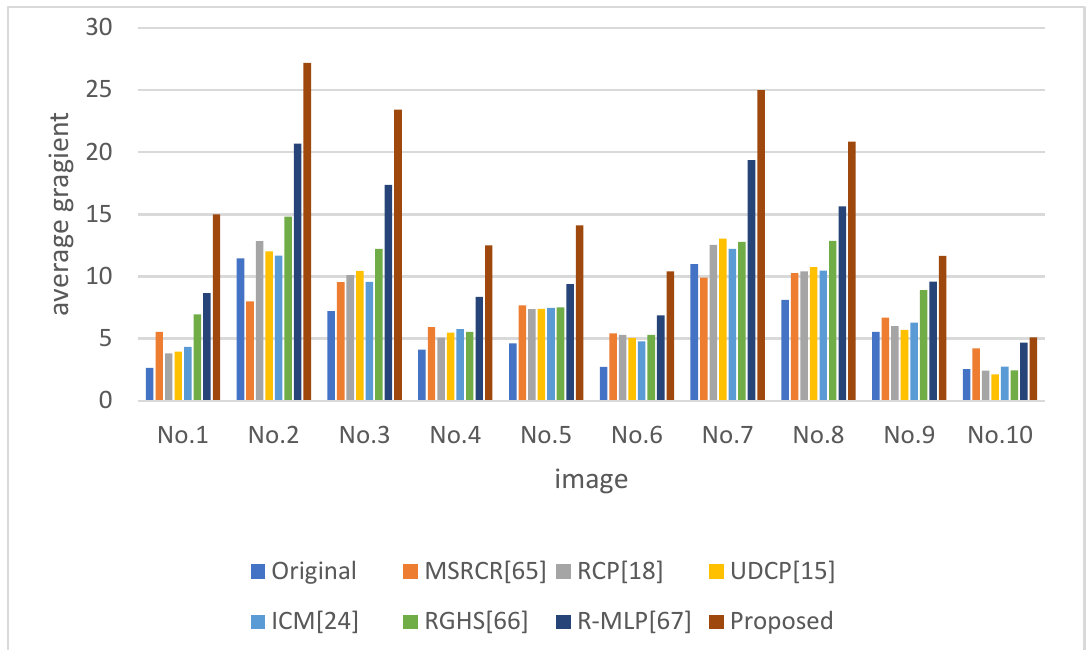
Figure 11. Comparison of average gradient [15,18,24,65–67].